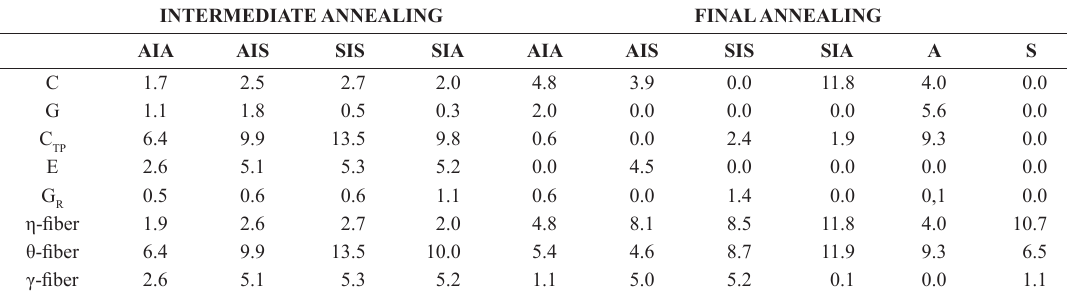
Table 2. Crystallographic texture of samples after intermediate and final annealing.